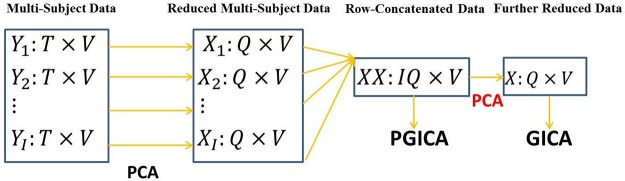
The work flow of PGICA.PCA is first applied to each subject for dimension reduction, then the dimension-reduced matrices are stacked together and PGICA is applied; as a comparison, a second dimension reduction step is usually required by fastICA algorithm. PGICA can potentially be used in combination with any of the existing back reconstruction methods such as dual regression and GIG-ICA.